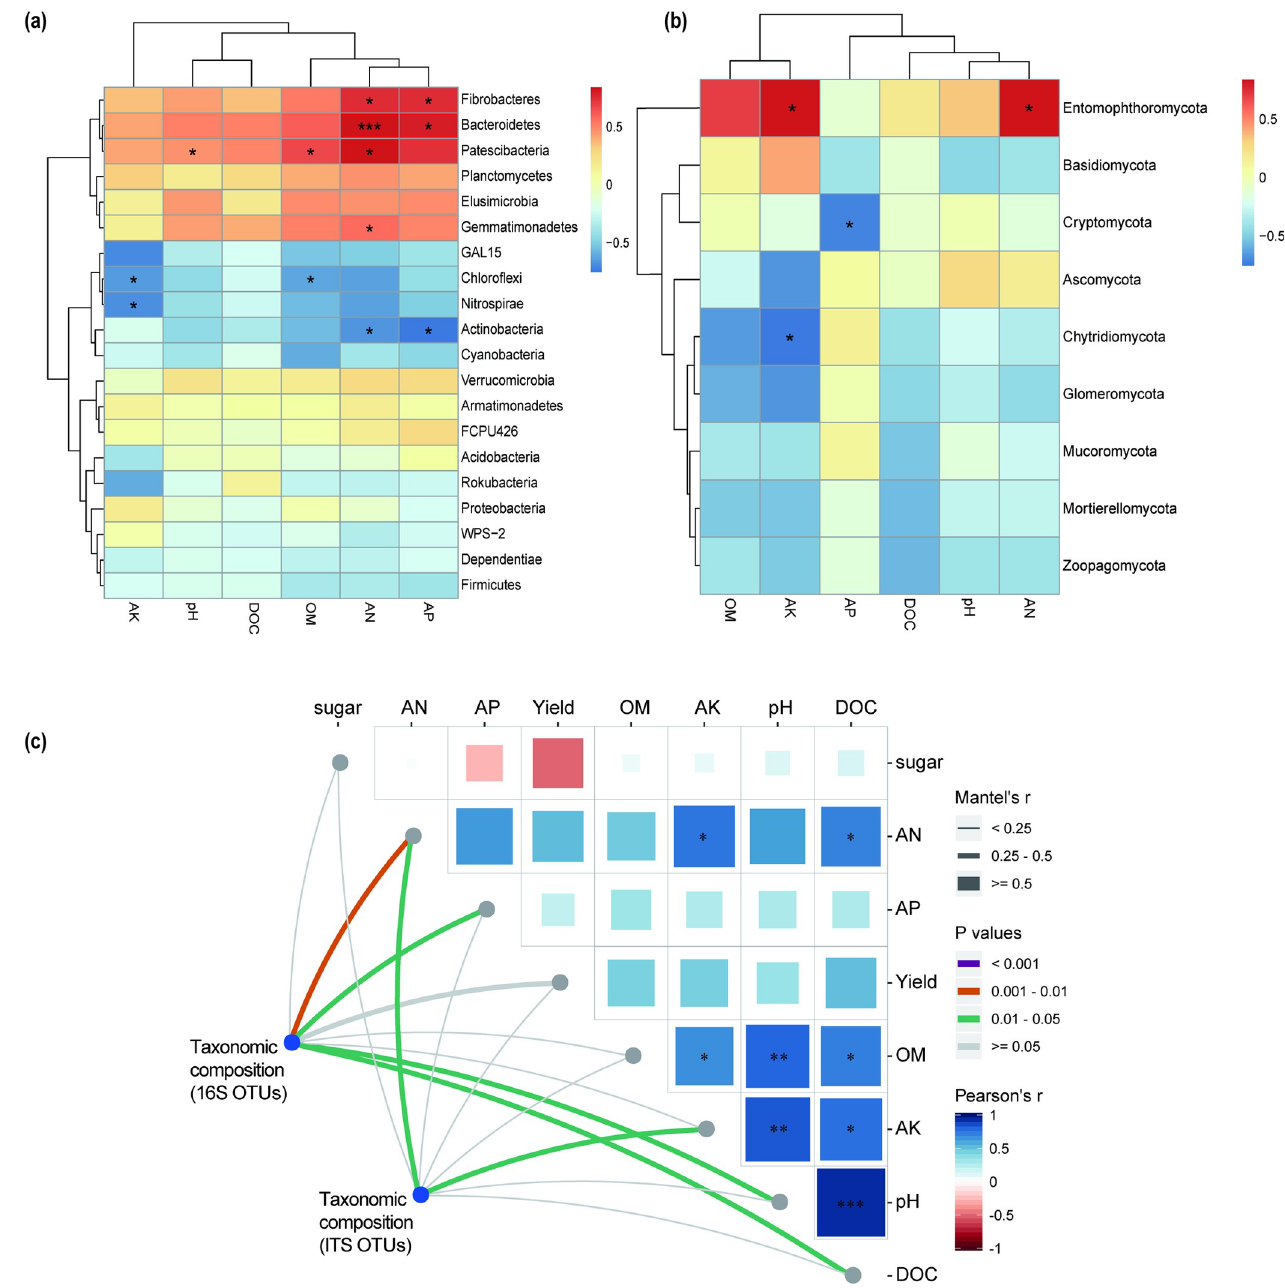
Fig 4. Correlation analysis between soil chemical properties and microbial community. Correlation between soil physiochemical properties and bacterial phyla (a), and fungus phyla (b) levels. Note: asterisk mark represents the level of significance. � 0.01 < p < 0.05, �� 0.001 < p < 0.01, ��� p < 0.001 (c) Pairwise comparisons of environmental factors are shown with a color gradient denoting Pearson’s correlation coefficients. Taxonomic [based on two independent methods: 16S OTUs, ITS OTUs] community composition was associated with each environmental factor by partial Mantel tests. Edge width corresponds to the Mantel’s r statistic for the corresponding distance